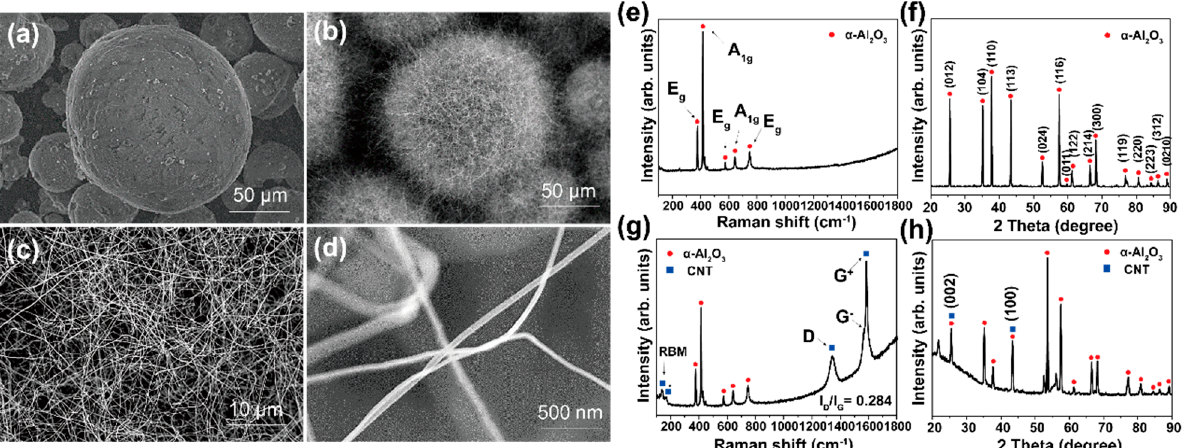
Figure 2. Low ‐ magnification SEM images obtained ( a ) before and ( b ) after the CNT growth on Al 2 O 3 powders, ( c ) and ( d ) show highly magnified SEM images. ( e ) Raman spectrum and (f) XRD profile from Al 2 O 3 powders. ( g ) Raman spectrum and ( h ) XRD profile from CNT grown on Al 2 O 3 powders at 825 °C using a conventional horizontal CVD chamber.